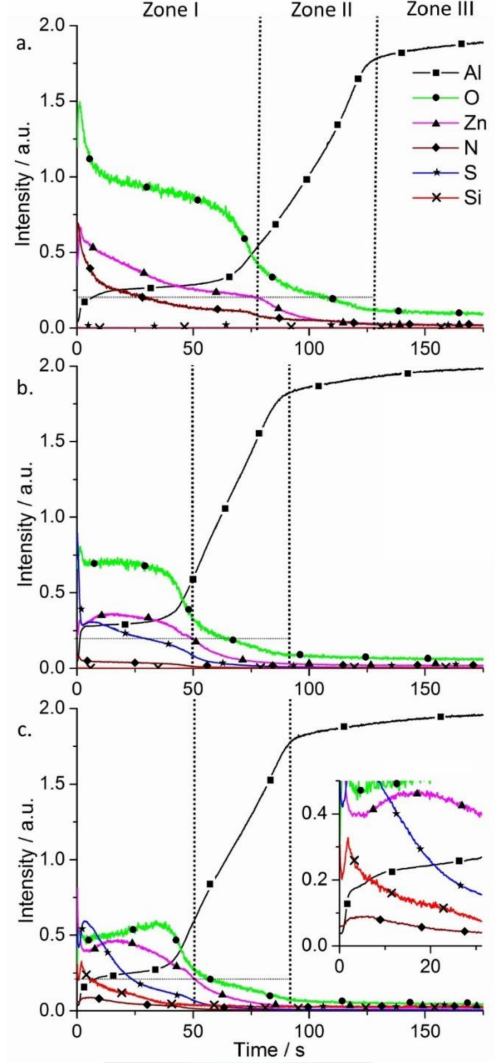
Figure 3. Qualitative glow discharge optical emission spectrometry (GDOES) depth profiles of AA2024 alloy plates after growth of SR-LDH films ( a ) SR-LDH-NO 3 ; ( b ) SR-LDH-MBT and ( c )